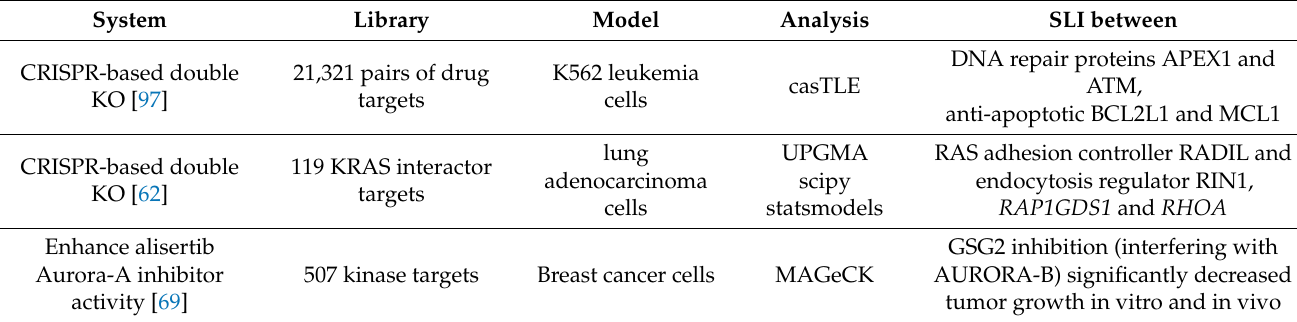
Table 1. Synthetic lethal CRISPR